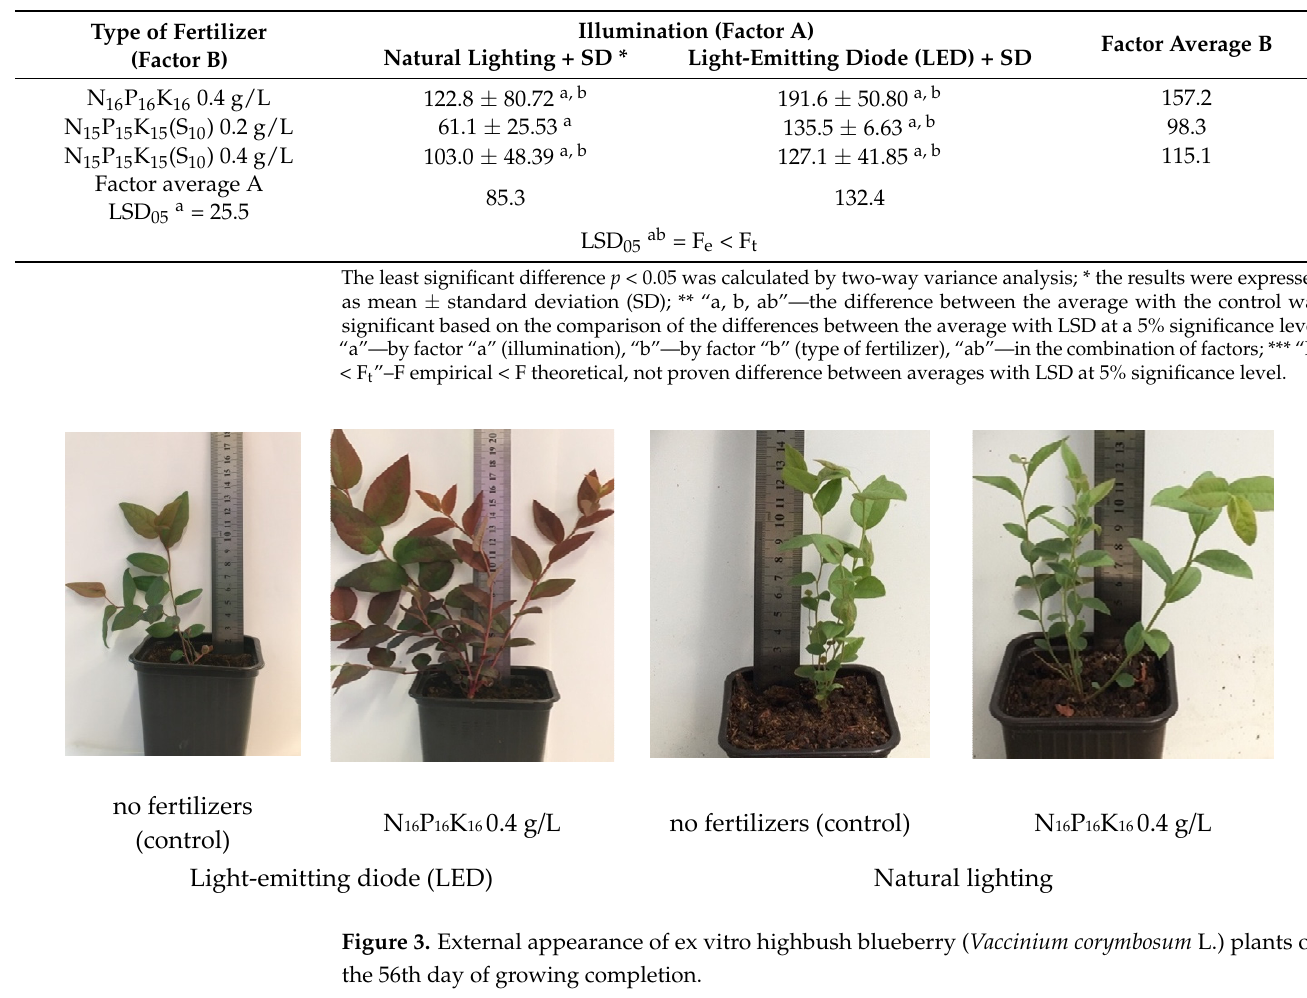
Table 5. Indices of chlorophyll content in the leaves in highbush blueberry ( Vaccinium corymbosum L.) cv. Brigitta Blue on the 56th day of growing completion.